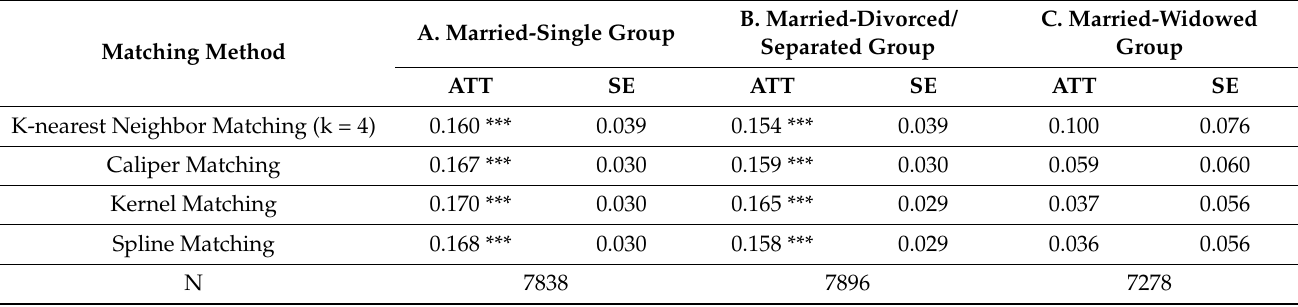
Table 6. Estimated average treatment effects on Life satisfaction changes in parents.